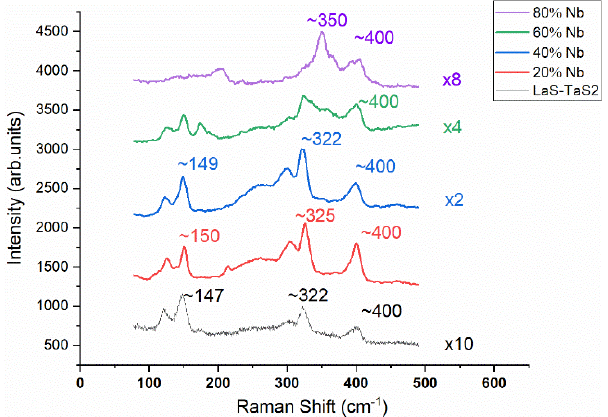
Figure 5. Raman spectra of five di ff erent LaS-Nb x Ta (1 − x) S 2 MLC tubes with di ff erent Nb content (adapted from [28] ).